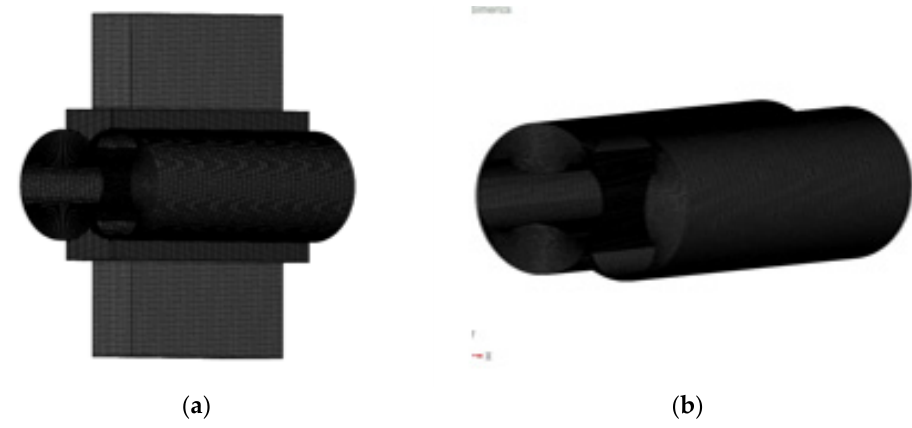
Figure 5. Grids of the Roots pump: ( a ) overall grid; ( b ) rotor grid.